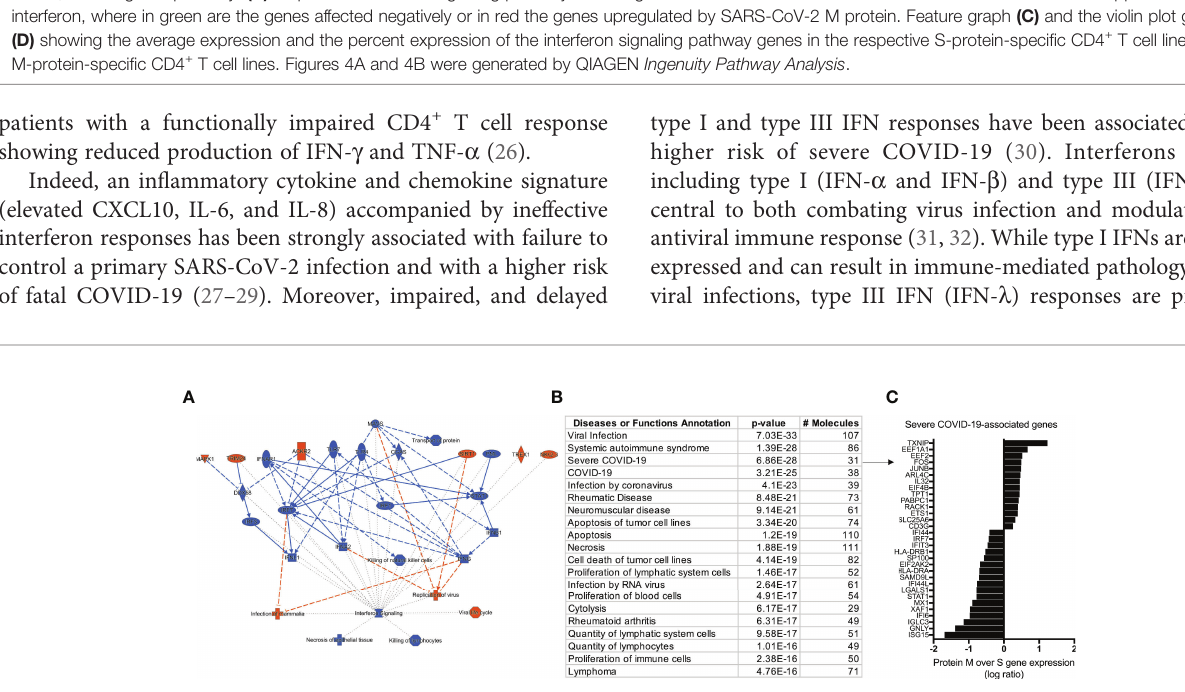
FIGURE 5 | IPA analysis demonstrating an overview summary of the major biological events in the transcriptome of SARS-CoV-2 M protein-reactive CD4 + TCLs (A) and The Disease or Function View highlighting how the SARS-Cov-2 speci fi c-CD4 + TCLs relate to other diseases and functions through the ingenuity ontology (B) . Severe COVID-19 associated genes that overlap with the marked differentially expressed genes in the SARS-Cov-2 M protein-reactive CD4 + TCLs (C) . Figure 5A was generated by QIAGEN Ingenuity Pathway Analysis .